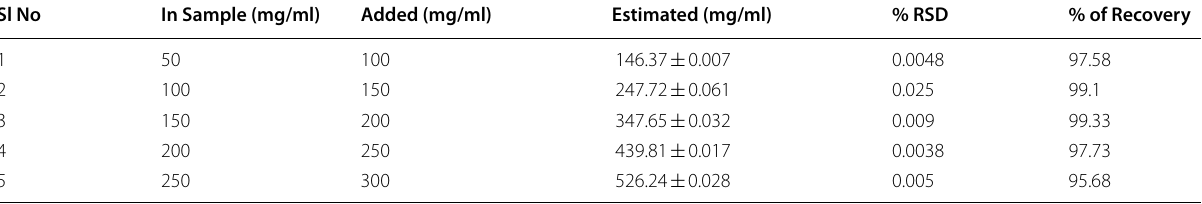
NB: Data are expressed as mean